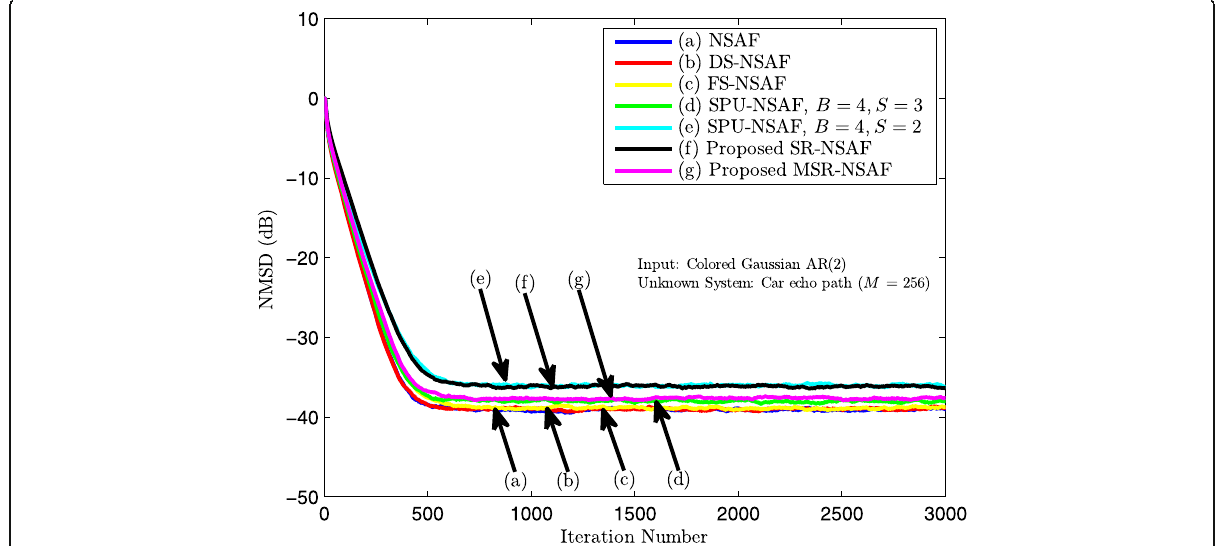
Fig. 6 NMSD learning curves of NSAF, DS-NSAF, FS-NSAF, SPU-NSAF, SR-NSAF, and MSR-NSAF with N = 8 and μ = 0.5